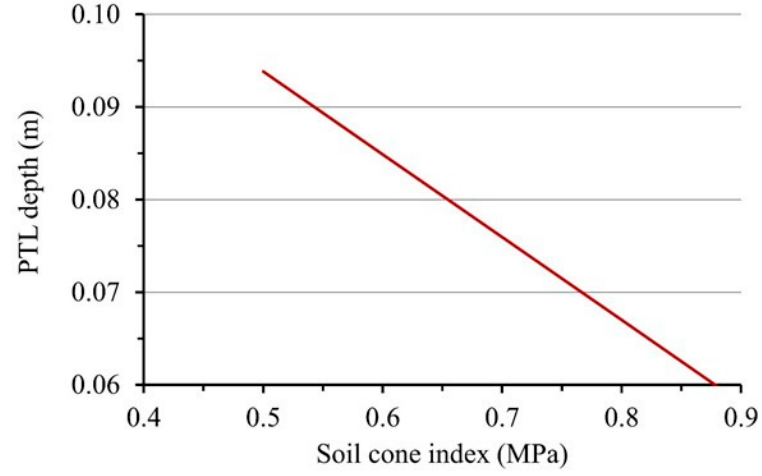
Figure 6. Dependence of the PTL track depth ( h ) on the soil density ( ρ ).